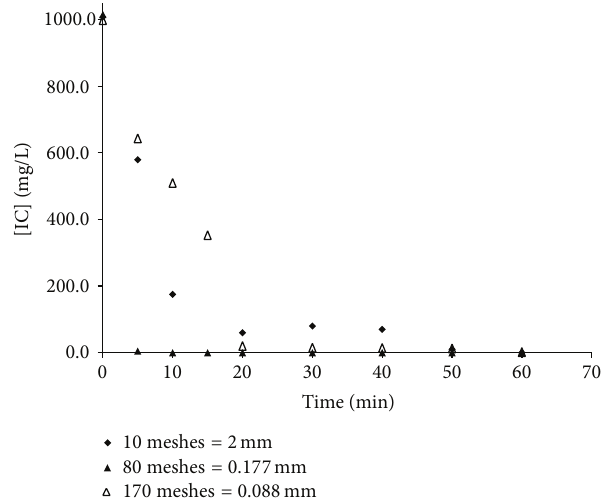
Figure 8: Effect of particle size of supported iron particles on indigo carmine concentration profile.